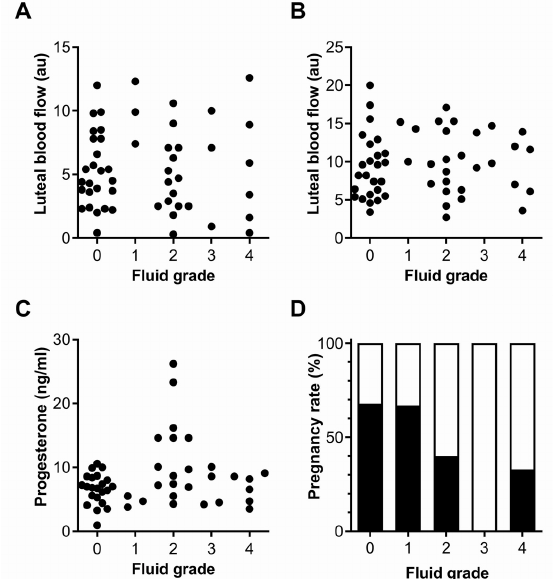
Figure 4. Fluid grade. ( A – C ) Scatterplots for luteal blood flow 3 days ( A ) and 6 days after ovulation ( B ), and for plasma progesterone concentrations 6 days after ovulation ( C ), for each fluid grade of endometritis. Grade 0 = NF. ( D ) Percent of cases by endometritis-fluid grade that did not conceive ( (cid:3) ) or resulted in pregnancy ( (cid:4) ).